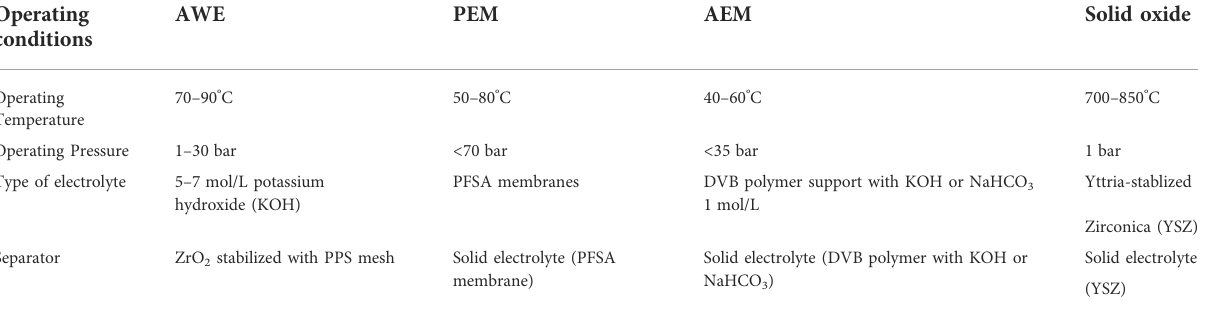
TABLE 1 Types of Electrolyzers and operating conditions (IRENA,